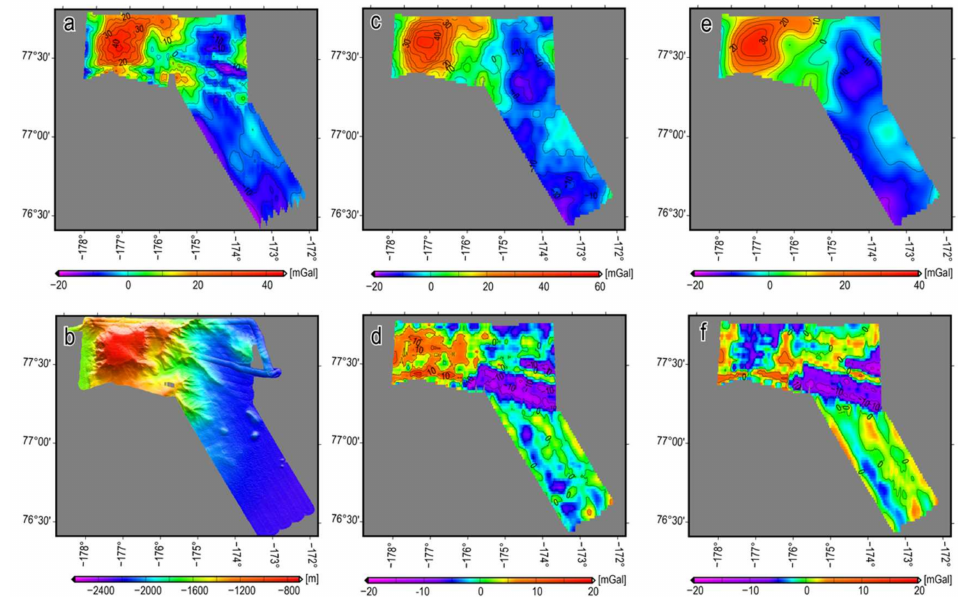
Figure 7. ( a ) Shipborne FAA map of Arctic-20. ( b ) Bathymetry of Arctic-20. ( c ) SV31 FAA map of Arctic-20. ( d ) Difference between shipborne and SV31 free-air gravity. ( e ) DTU21 FAA map of Arctic-20. ( f ) Difference between shipborne and DTU21 free-air